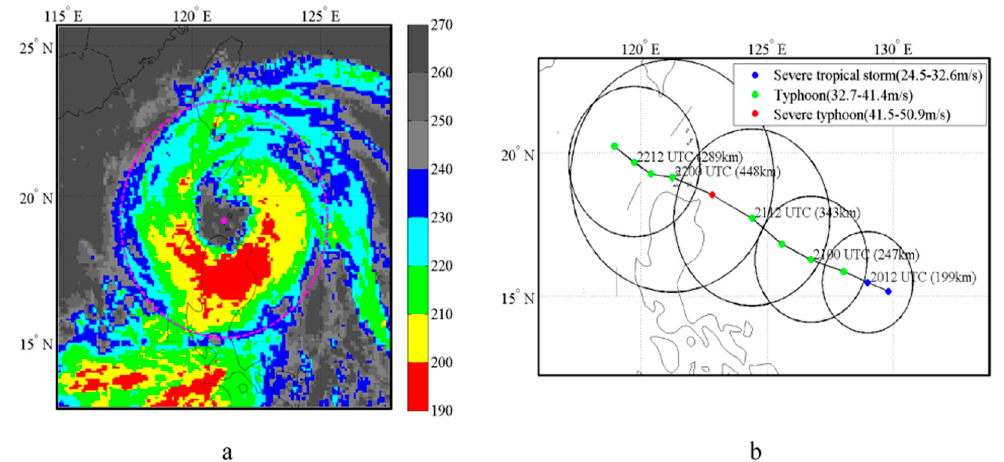
Figure 6. The brightness temperature distribution of TC Hal (1985) and its size change with intensity variation. ( a ) TC Hal at 0000 UTC on 22 June 1985, observed by GMS-3. The pink dashed circle and central point represent the size field and center of the TCs, respectively. ( b ) Size change of TC Hal (1985) as indicated by circles that have a radius (indicated in parentheses) at 0000 and 0012 UTC daily. The date and time in UTC are also indicated.